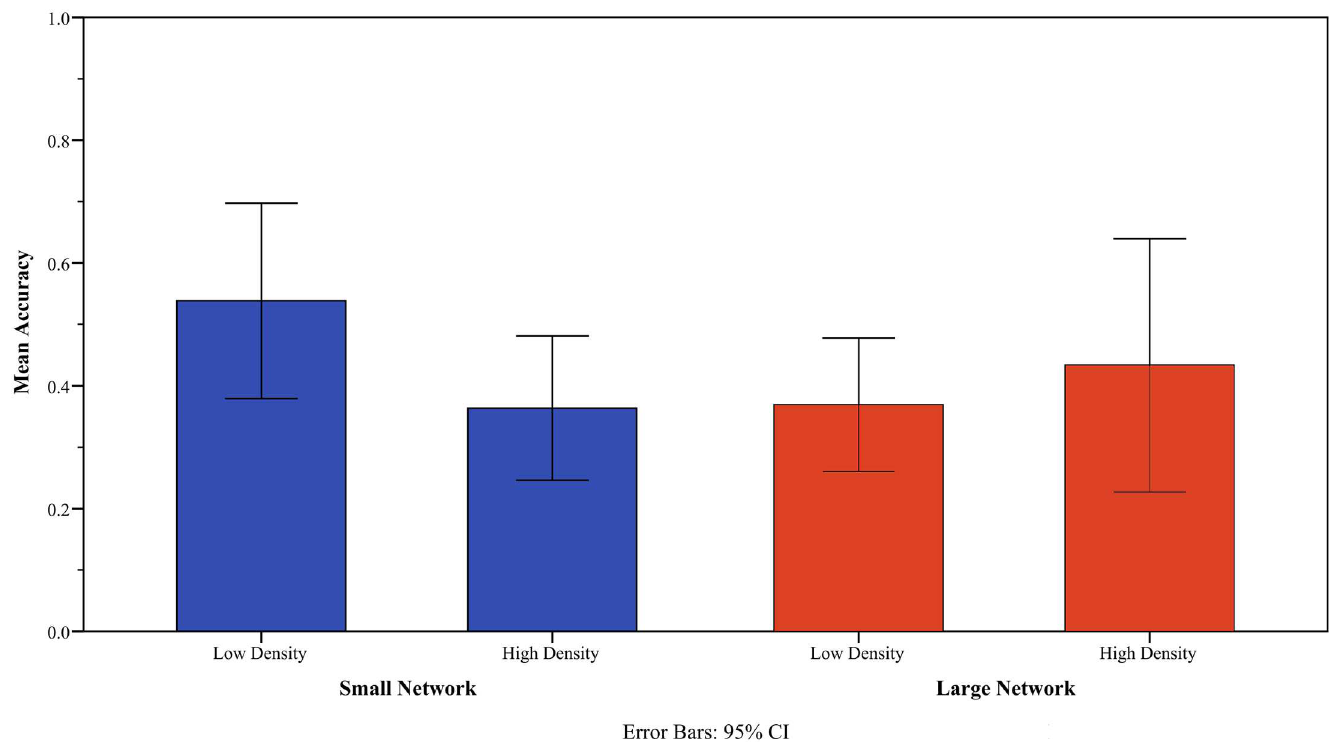
Fig 7. Network density, network size and prediction accuracy. The responsevariableis the averagerate of predictingcorrectly the outcomesof the Go match. N =